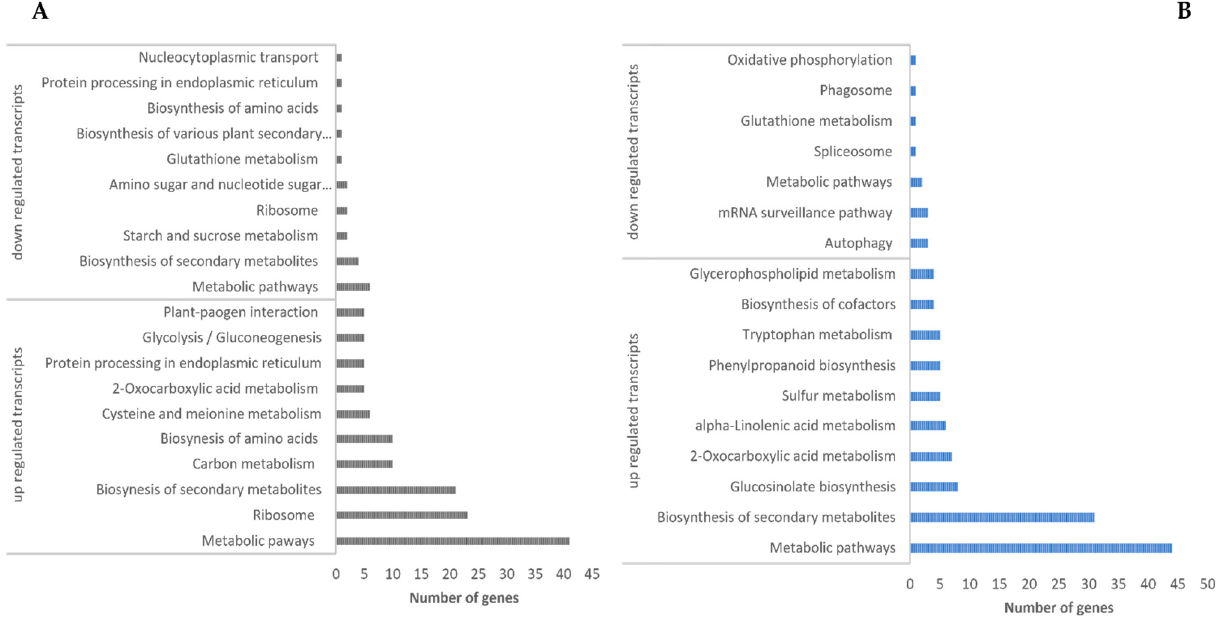
Figure 5. Top pathways of DEGs in roots ( A ) and aboveground parts ( B ) of H. incana in response to Pb exposure.